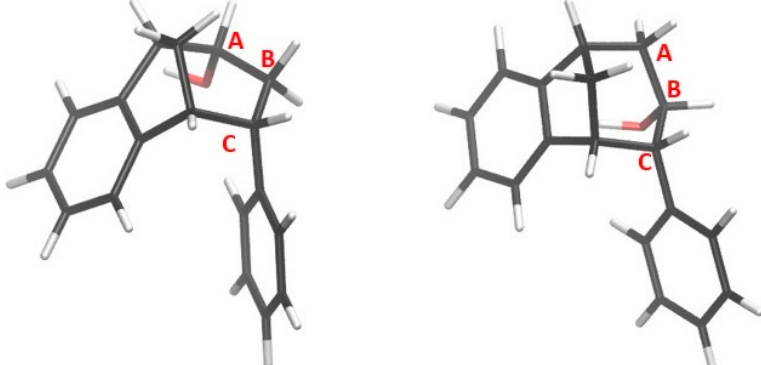
Figure 9. Alcohols derived from products of reactions (3) and (4).